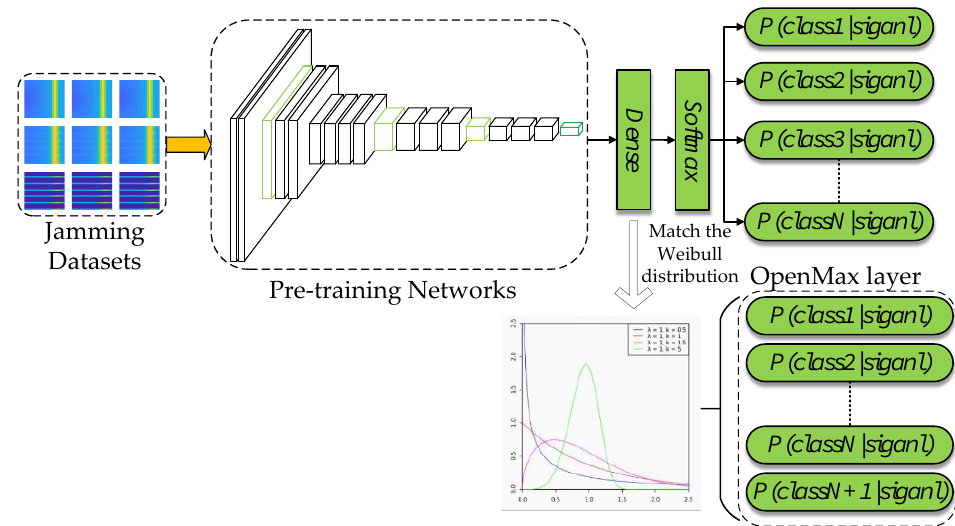
Figure 11. The structure of the OSR model based on OpenMax.